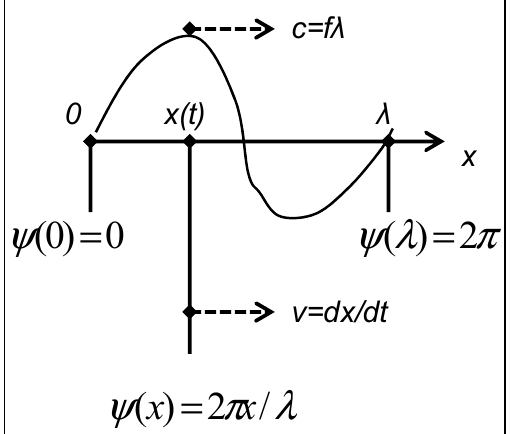
Figure A1. Derivation of axial Doppler shift.